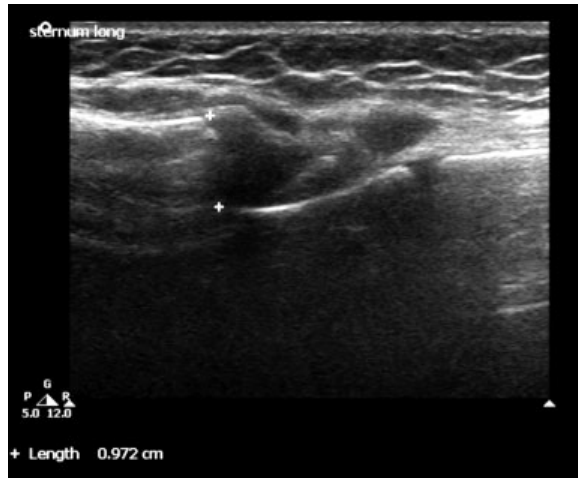
Fig. 1 Longitudinal ultrasonic image showing the transverse fracture of the manubrium sterni with dorsal displacement of the distal fragment by 0.97 cm.